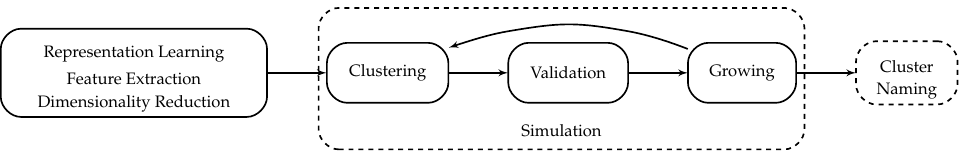
Figure 1. Sequence of operations in the MorphoCluster approach. The simulation is not part of the MorphoCluster application but allows us to examine different algorithmic configurations. In this work, we focus on the representation learning and the iterative annotation phase and omit the final naming step. We compare different approaches for representation learning, dimensionality reduction and